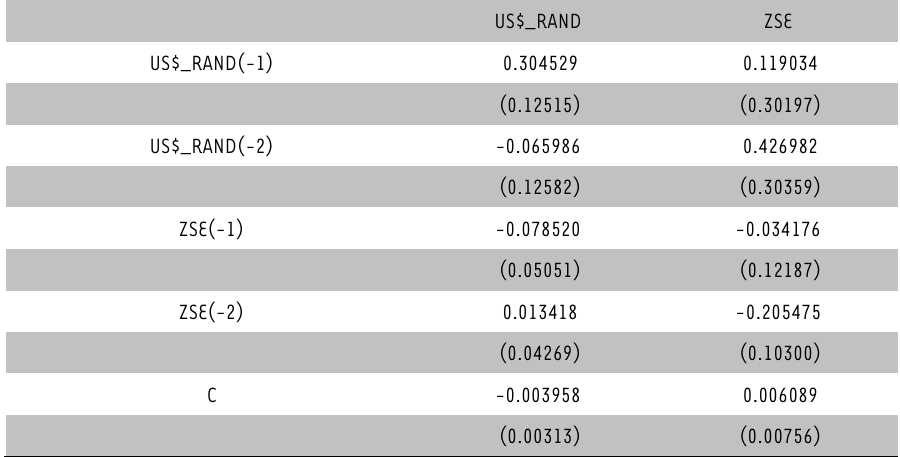
TABLE 3: Short-run dynamics between the US Dollar/Rand and ZSE industrial index